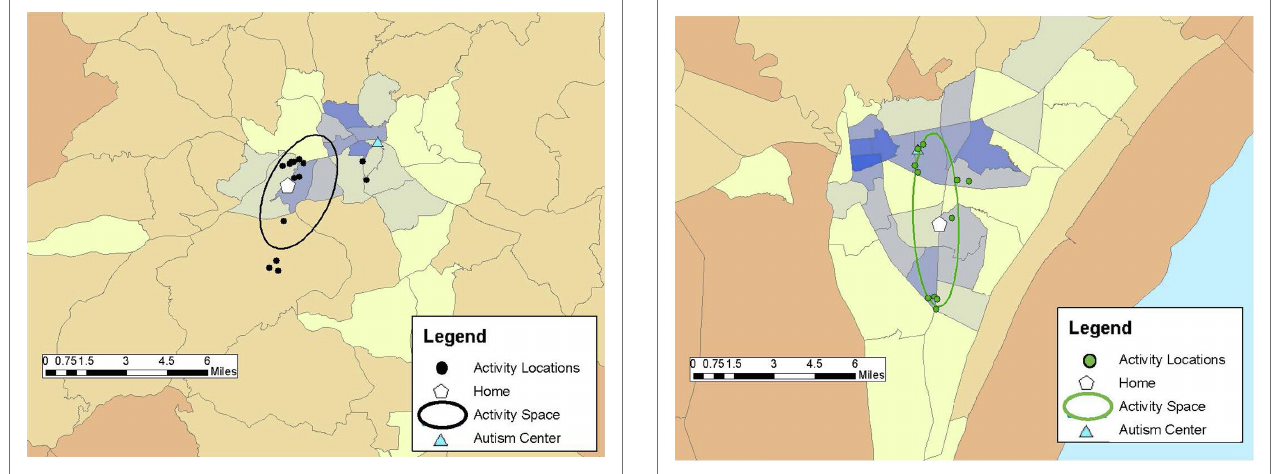
FIGURE 2 | John’s activity space (8.51 mi 2 ) based on visiting several locations clustered close to his home and to each other during the 1-week study